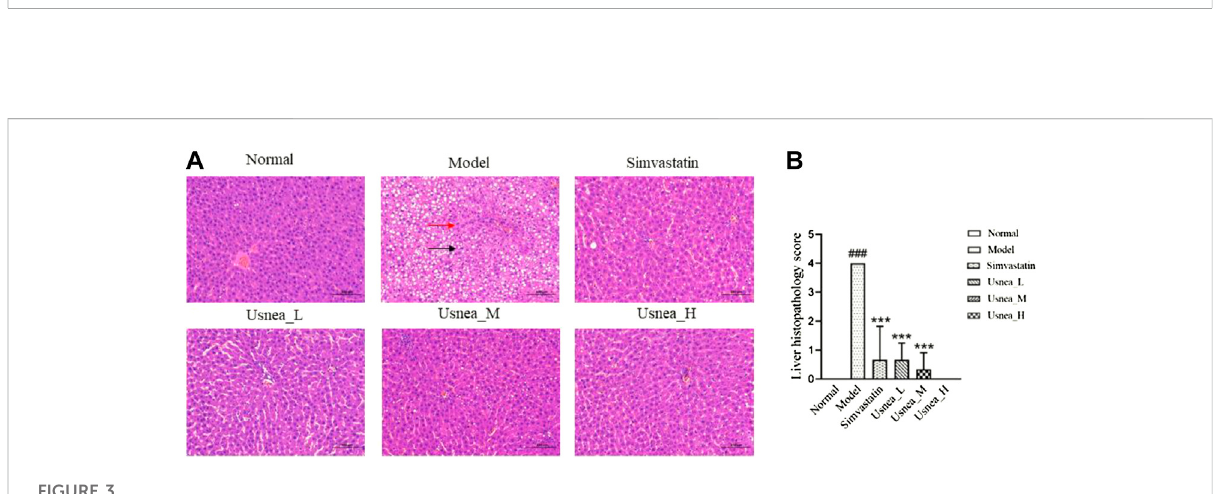
FIGURE 3 Pathological status of the liver in each group of rats (200 × ). (A) In AS rats, the liver exhibited diffuse hepatocyte granular degeneration with a swollen cytosol and a loose and lightly stained cytoplasm (black arrow), a large number of hepatocytes with steatosis, and a variable number of tiny round vacuoles in the cytoplasm (red arrow). Results are expressed as the mean ± SD ( n = 6 per group). (B) Liver histopathological score, n = 3. Compared with the normal group, ### p < 0.001; compared with the model group, ** p < 0.01, *** p <